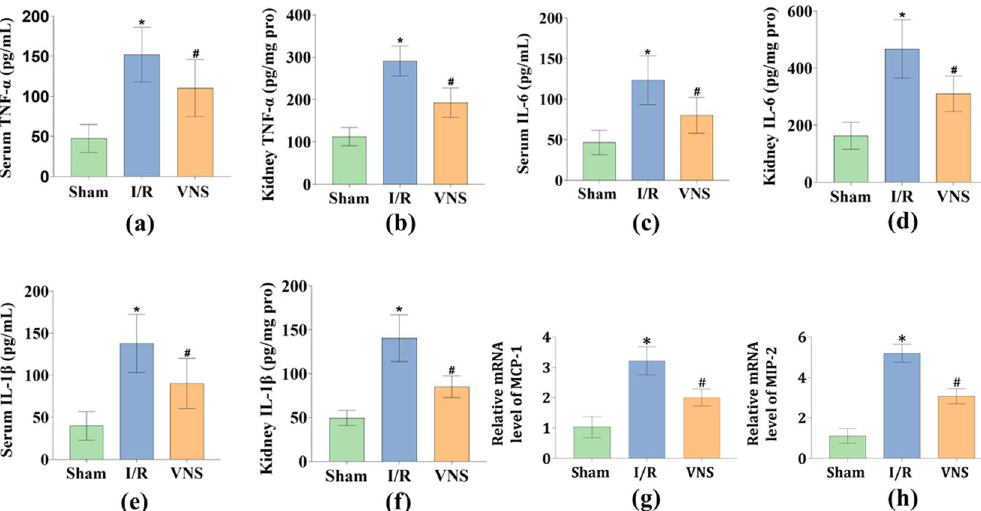
Figure 2. VNS mitigates inflammation in the serum and kidneys after hepatic I/R injury. The effect of VNS on the serum and kidney tissues levels of ( a , b ) TNF-α, ( c , d ) IL-6, and ( e , f ) IL-1β is shown. The relative mRNA levels of ( g ) MCP-1 and ( h ) MIP-2 in kidney tissues from the three groups are shown. Data are presented as mean ± SD. *p < 0.05 versus the Sham group; # p < 0.05 versus the I/R group. TNF-α tumor necrosis factor